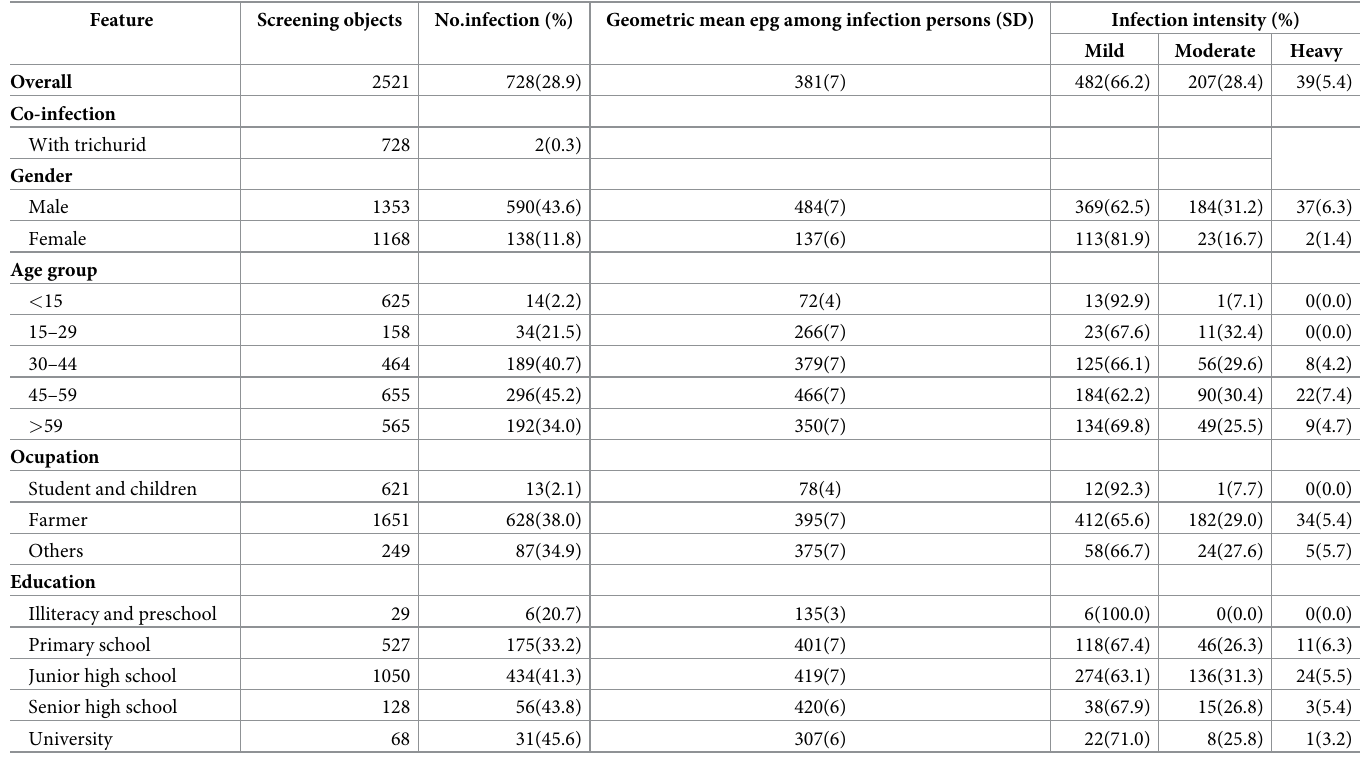
Table 1. Demographic and Infection Intensity Characteristics of the Screened Subjects in Binyang